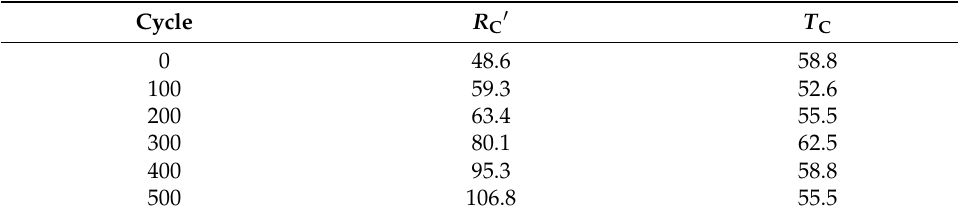
Table 1. Coefficient of approximate function shown in Equation (13).